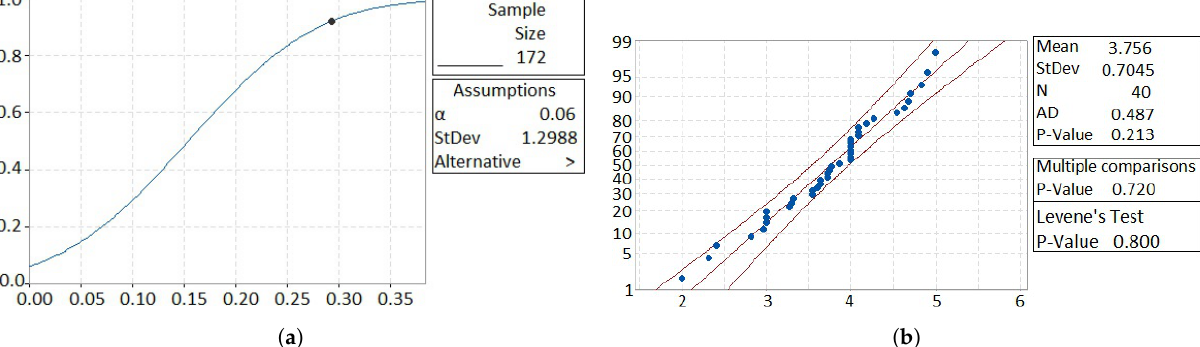
Figure 17. Statistical significance, power, and normality of samples and results. ( a ) Power curve for 1-Sample Z Test with α = 0.06. ( b ) Normal probability plot of answers with 94% confidence